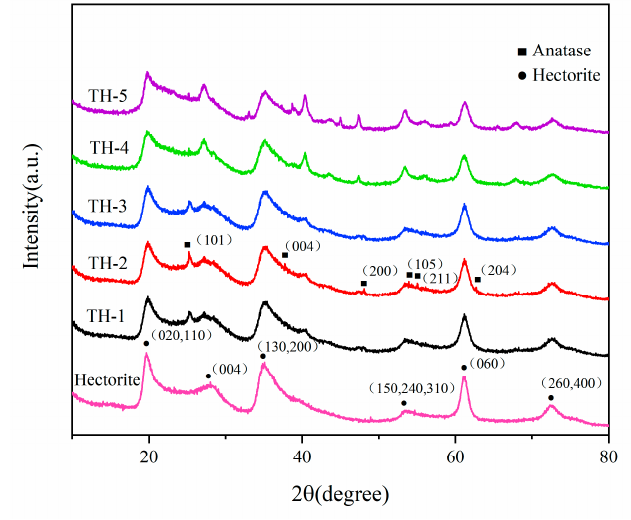
Figure 1. XRD patterns of hectorite: TH-1, TH-2, TH-3, TH-4, and TH-5. TiO 2 shows the characteristic diffraction peaks of the anatase phase (Joint Committee on Powder Diffraction Standards Card NO. 21-1272) at 25.3, 37.8, 48.06, 54.0, 55.07, and 62.8 ◦ , which correspond to the diffraction planes of (101), (004), (200), (105), (211), and (204) [10]. The same diffraction peaks are found for the TiO 2 /hectorite photocatalysts with different molar ratios of Li, Mg, and Si. However, the characteristic peaks of